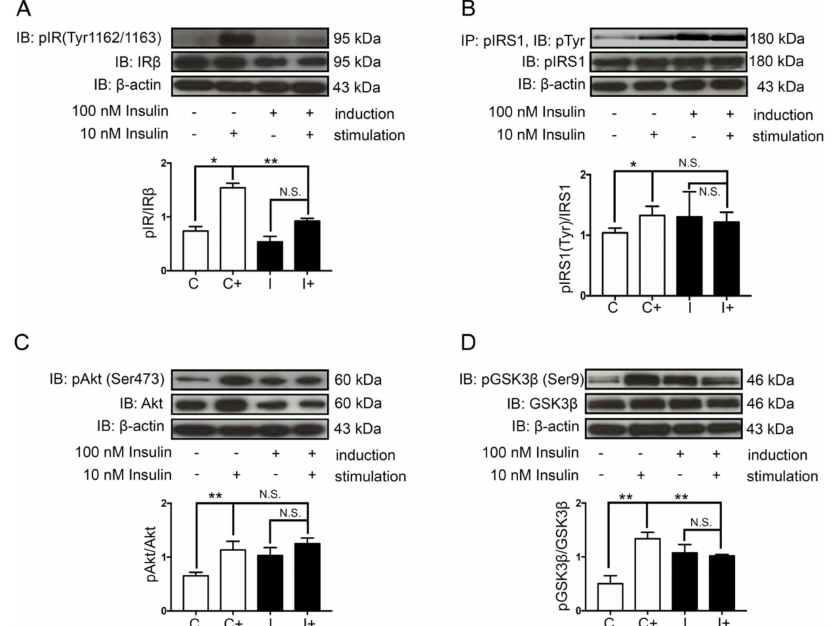
Figure 2. Effects of hyperinsulinemic conditions on insulin signaling pathway. The normal cells (C) and insulin-resistant cells (I) were subdivided and stimulated with 10 nM insulin (C + , I + ) or without (C, I) for 30 min before harvesting. Western blotting bands and bar graphs represent densitometric values of each lane after normalizing with total protein expression; phosphorylated insulin receptor (pIR) (Tyr1162 / 1163) / IR β ( A ) pAKT(Ser473) / AKT ( C ), pGSK-3 β (Ser9) / GSK-3 β ( D ). The bands and bar graphs of immunoprecipitated insulin receptor substrate 1 (IRS-1) followed by pTyr Western blotting of pIRS-1(Tyr) / IRS-1 representing densitometric values of each lane are shown in ( B ). Values are mean ± SEM, * p < 0.05, ** p < 0.01 compared with those of normal cells. All experiments shown were from n =